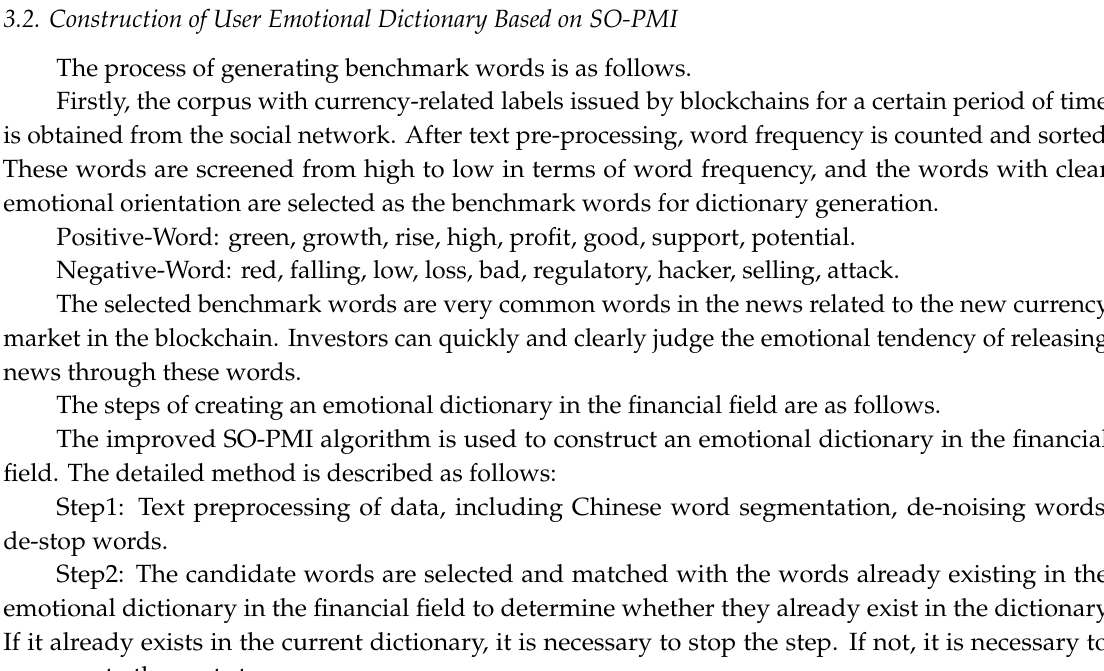
Figure 1. Dictionary method based on TRIE index tree .